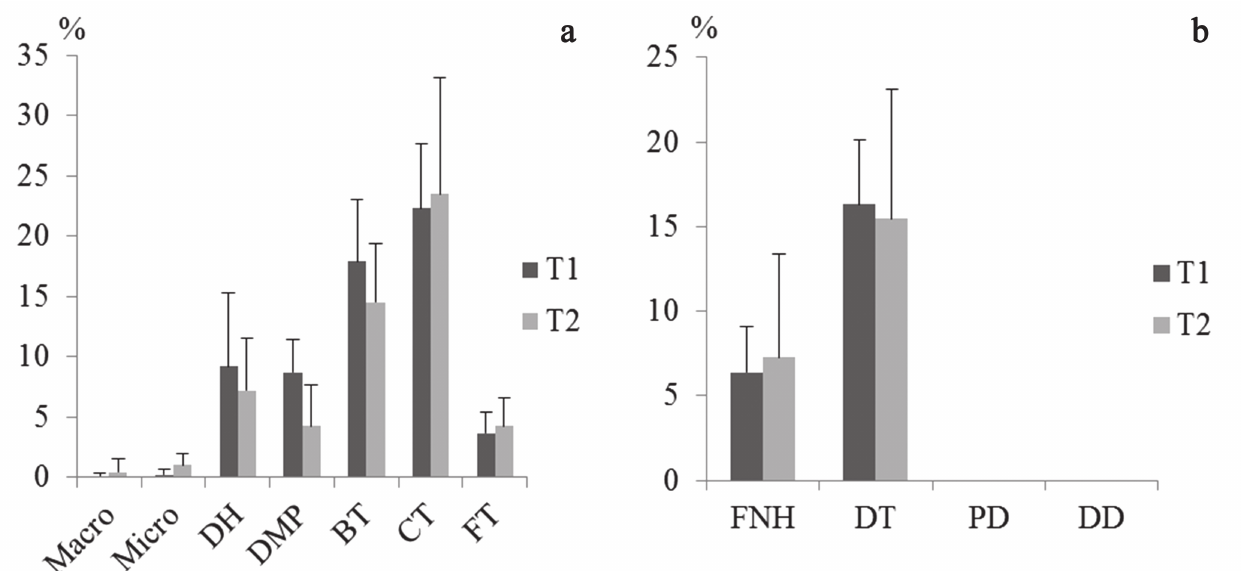
Fig. 3 . The average percentage of damage found in frozen semen of Colossoma macropomum in different treatments. (a) Primary damage: Macrocephaly (Macro); Microcephaly (Micro); Head Degeneration (HD); Degenerated Midpiece (DMP); Curly Tail (CT); Broken Tail (BT); Folded Tail (FT). (b) Secondary damage: Degenerated Tail (DeT); Free Normal Head (FNH); Distal Droplet (DD); Proximal Droplet